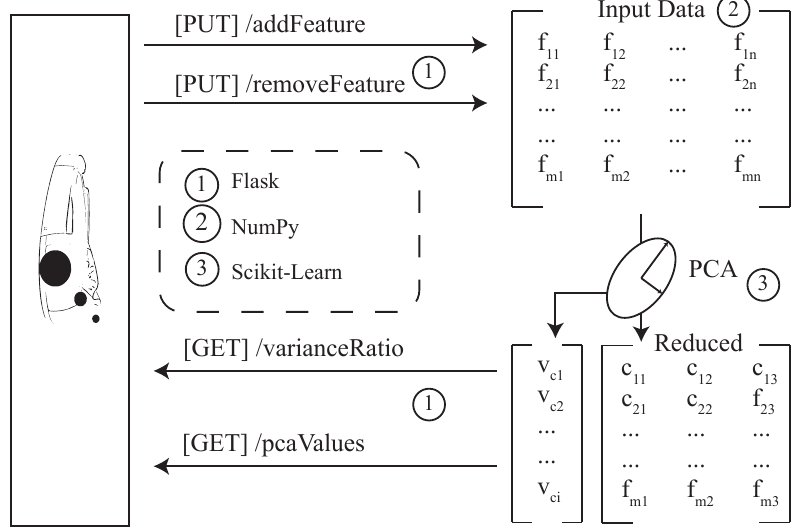
Figure 9. Backend Strategy for providing the PCA-related features. A RESTful-driven architecture is chosen to offer the possibility of working with the infrastructure as a distributed